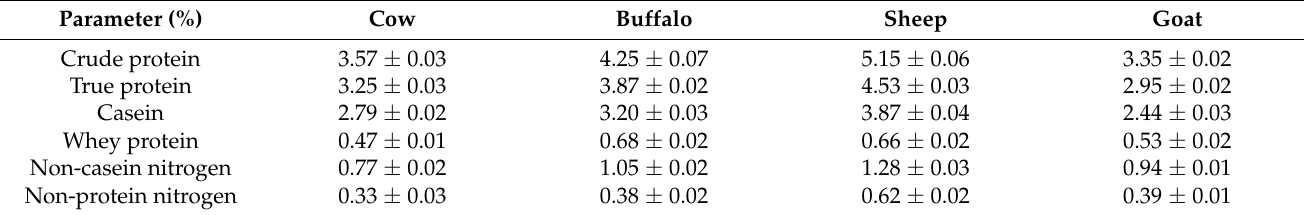
Table 6. Milk protein fractions in milk from different